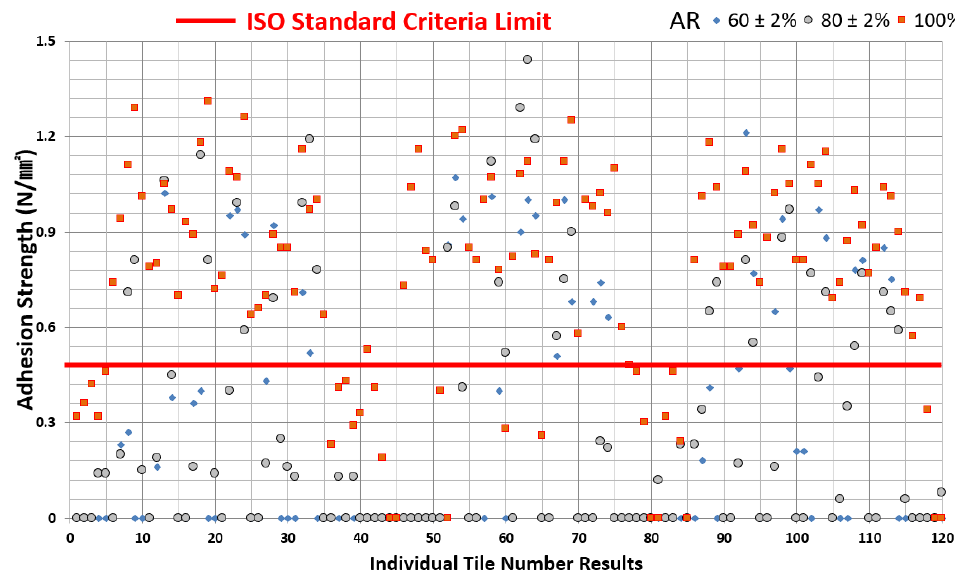
Figure 17. Comprehensive comparison of different AR-conditioned tile pieces.